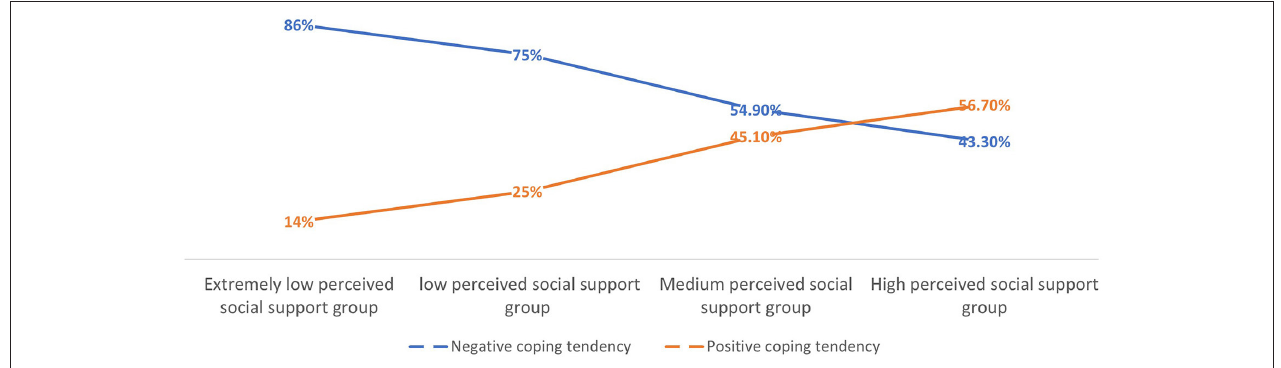
FIGURE 2 | Trends for subclasses of different perceived levels of social support-coping styles.